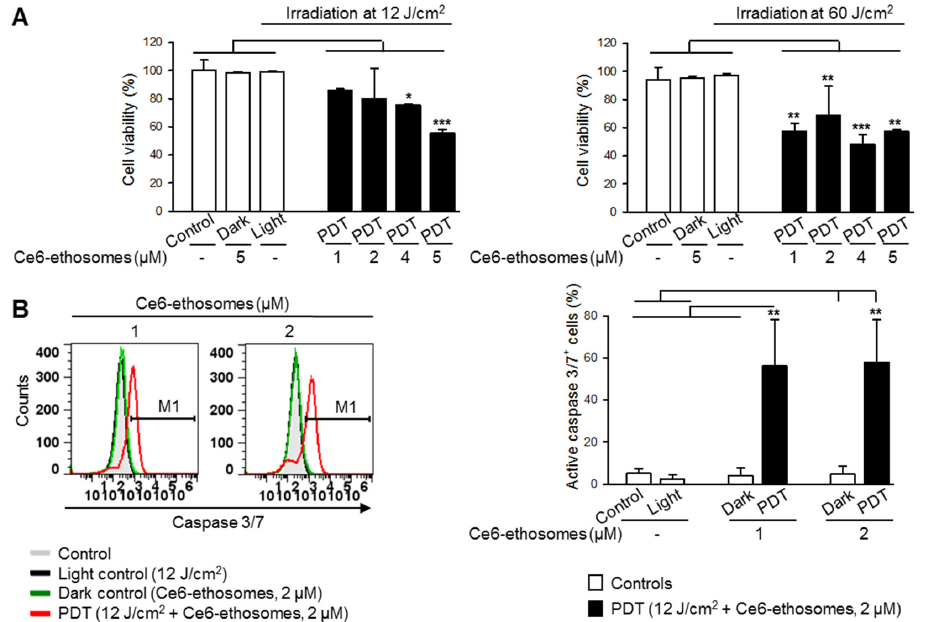
Figure 3. Ce6 ethosomes induce apoptosis in squamous cell carcinoma cells. ( A ) Viability of A431